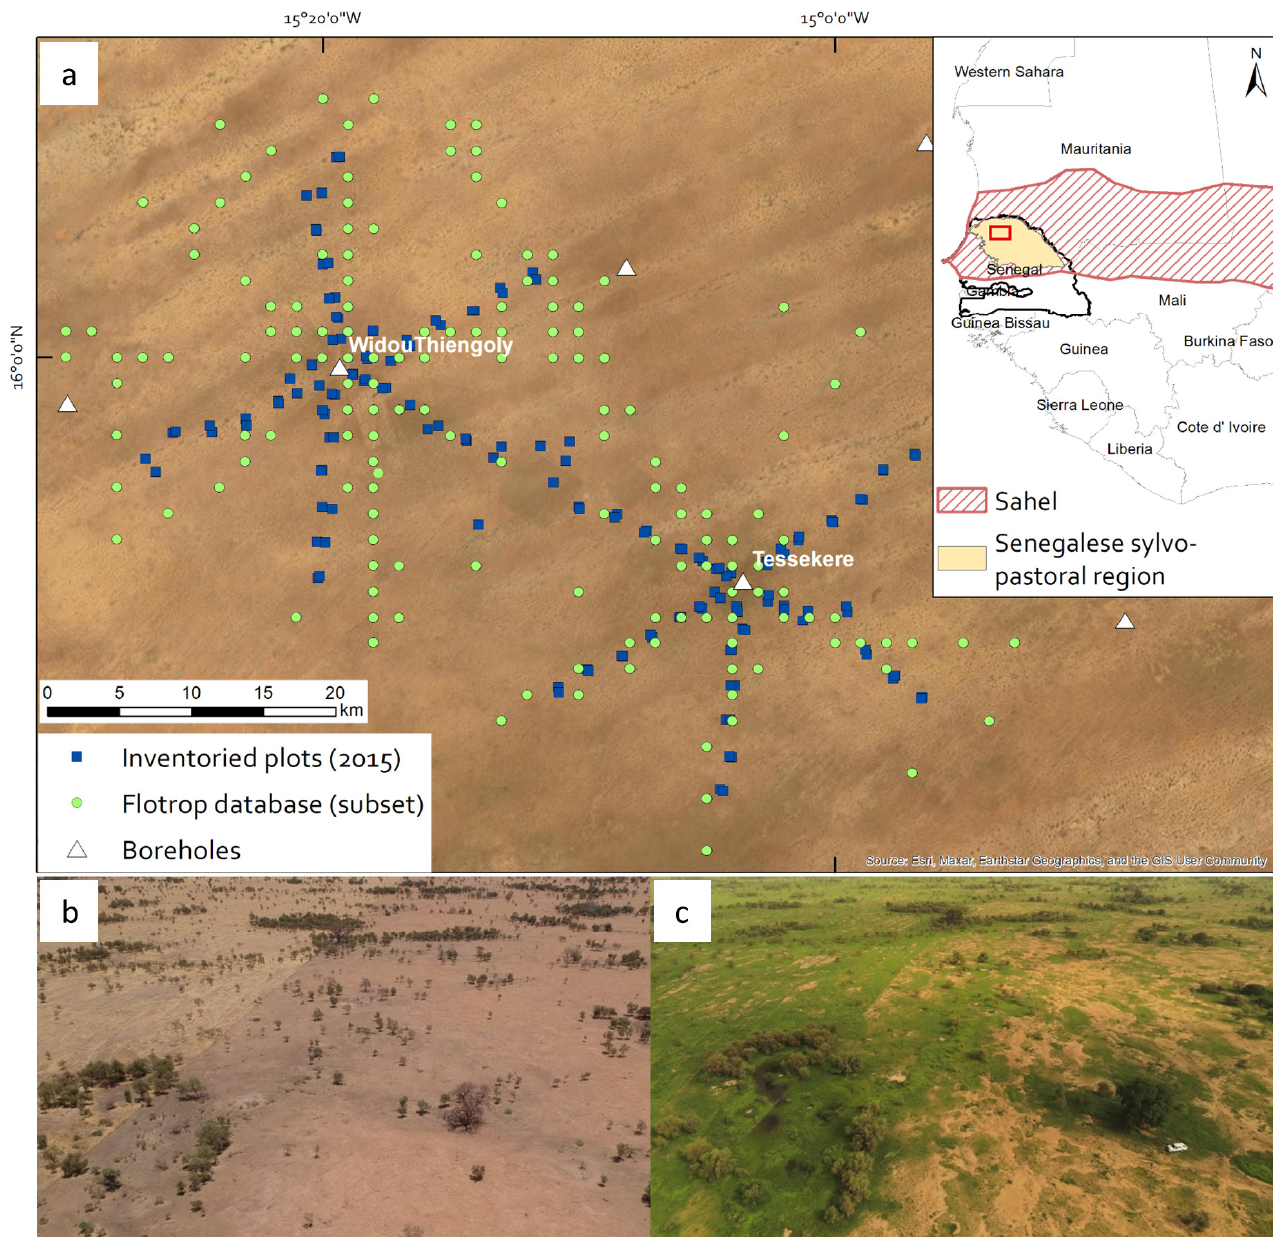
Figure 1. The sandy sylvopastoral region of Senegal (Ferlo). ( a ) Plots inventoried in 2015 by Dendoncker and Vincke [11], and subset of the Flotrop database [66] in the study area. ( b , c ) UAV photographs of the savanna near Widou Thiengoly, during the dry season (in May), ( b ) and during the rainy season, at the same location, (( c ) in August). Topographical depressions are particularly visible during the dry season (areas with trees clustering).